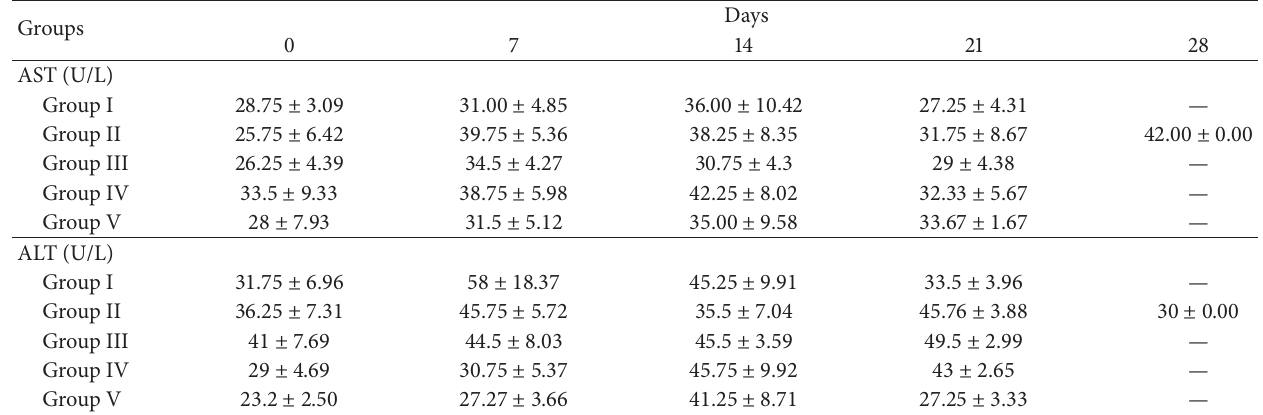
Table 8: AST and ALT in different groups at various observation intervals (mean ± S.E.).